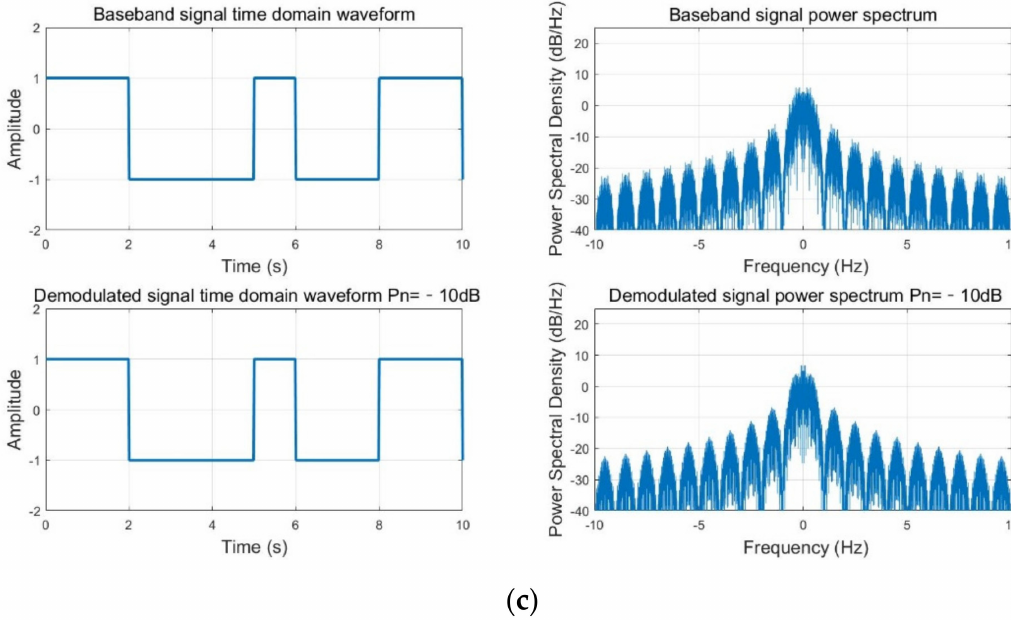
Figure 19. Signal performance diagram. ( a ) The time—domain performance diagram of the upper branch signal and the time domain performance diagram after the multiplier, low—pass filter and sampling decision; ( b ) The time—domain performance diagram of the lower branch signal and the time—domain performance diagram after the multiplier, low—pass filter and sampling decision; ( c ) Time domain waveform and power spectrum of baseband signal and demodulation signal.